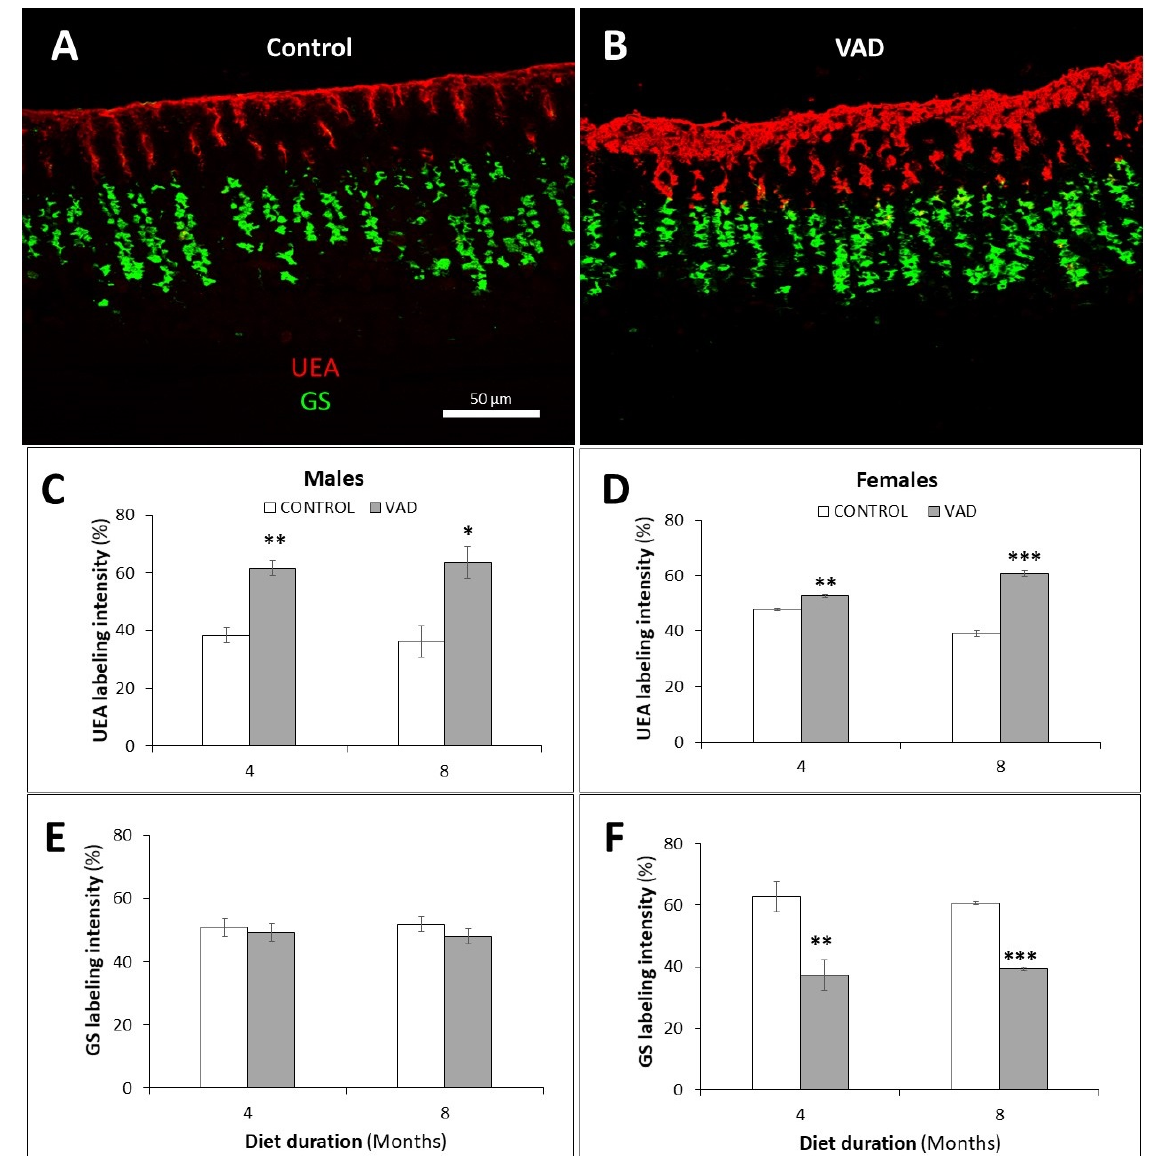
Figure 7. Lectin labeling of mucus-secreting pit and neck cells in the gastric glands of control ( A ) and VAD ( B ) male mice. Rhodamine-conjugated UEA (red) and FITC-conjugated GS (green) lectins bind to pit and neck cells, respectively. The labeling intensities of UEA ( C , D ) and GS ( E , F ) in control and VAD glandular mucosae of male and female 4- and 8-month mice are presented as mean ± SE. Scale bars in A and B = 50 µm. * p < 0.05, ** p < 0.01, and *** p < 0.001. Since pit and neck mucous cells also produce TFFs which are associated with mucus and involved in mucosal protection, tissue sections of control and VAD stomachs were probed with antibodies specific for TFF1 and TFF2. The 4- and 8-month VAD male mice showed an increase in TFF1 labeling intensity (Figures 8A–D and S3A,B). However, the differences were only significant in the 4-month group, p = 0.00005, not in the 8-month, p = 0.060. In female mice, no significant change was detected in the TFF1 labeling of control and VAD mice at both 4 and 8 months (Figure 8D).